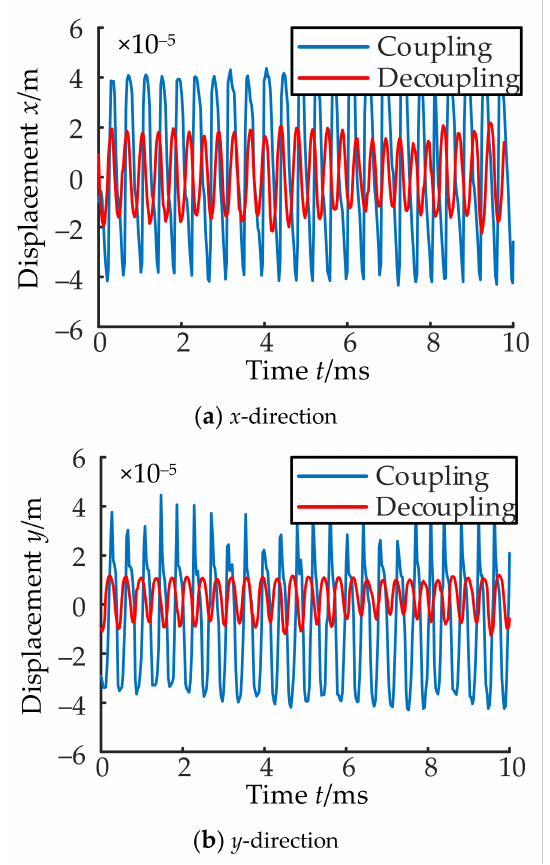
Figure 19. Displacement of the rotor without